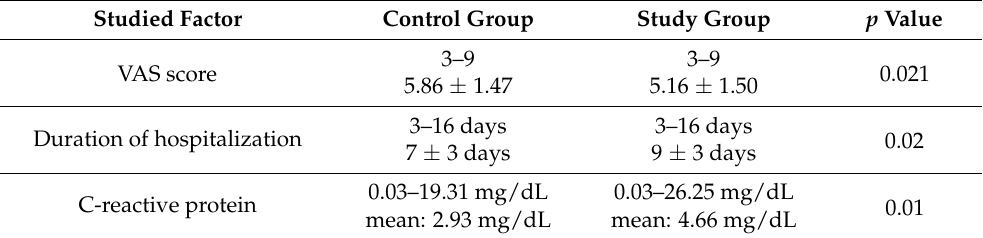
Table 2. Significant research outcomes.